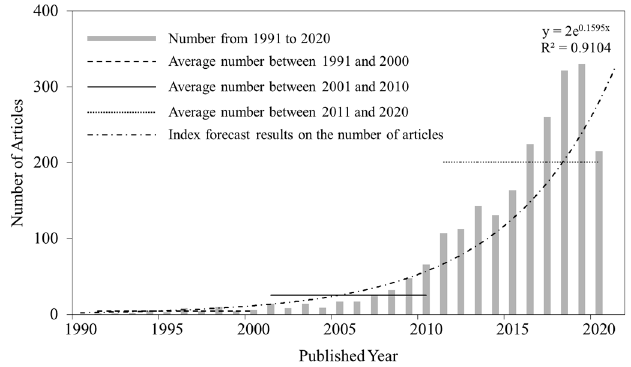
Figure 1. The number of annual research articles on household CO 2 emissions (HCEs) from 1991 to 2020.